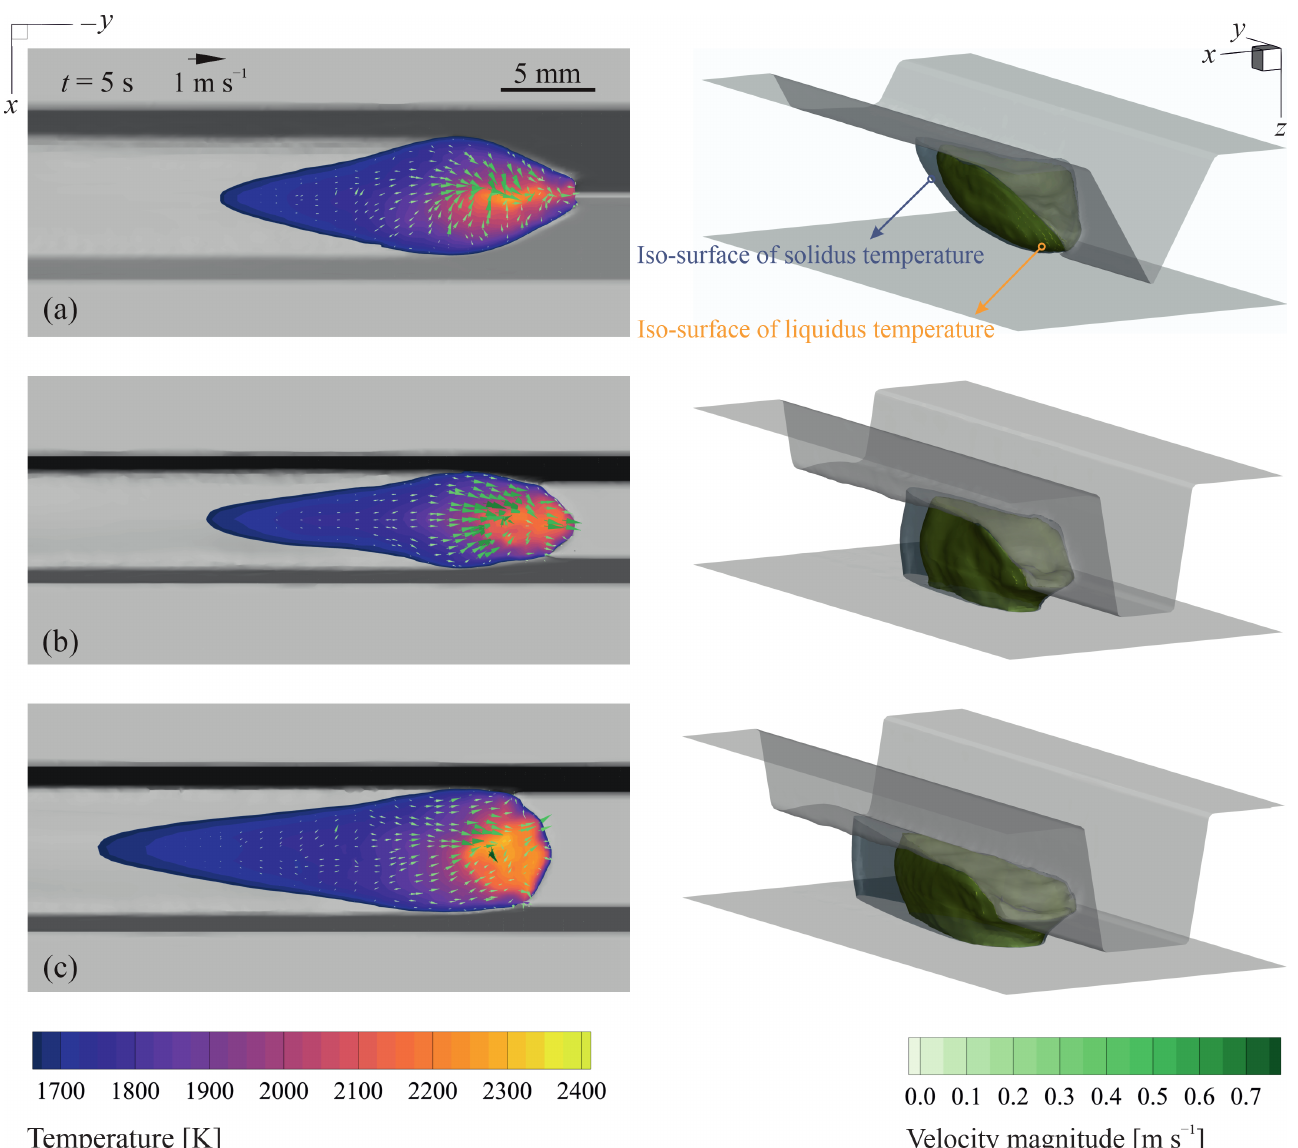
Figure 5. The numerically predicted thermal and fluid fields over the melt-pool surface (left column) and the corresponding pool shape (right column) for different joint shapes at t = 5s. ( a ) groove angle θ = 60 ◦ and no root-leg ( W r = 0mm), ( b ) θ = 20 ◦ and root-leg width W r = 4mm and ( c ) θ = 20 ◦ and root-leg width W r = 6mm. Wire feed rate u w = 7mmin − 1 , welding current I = 220A, and travel speed V = 7.5ms − 1 . The area between iso-surfaces of solidus and liquidus temperature shows the mushy